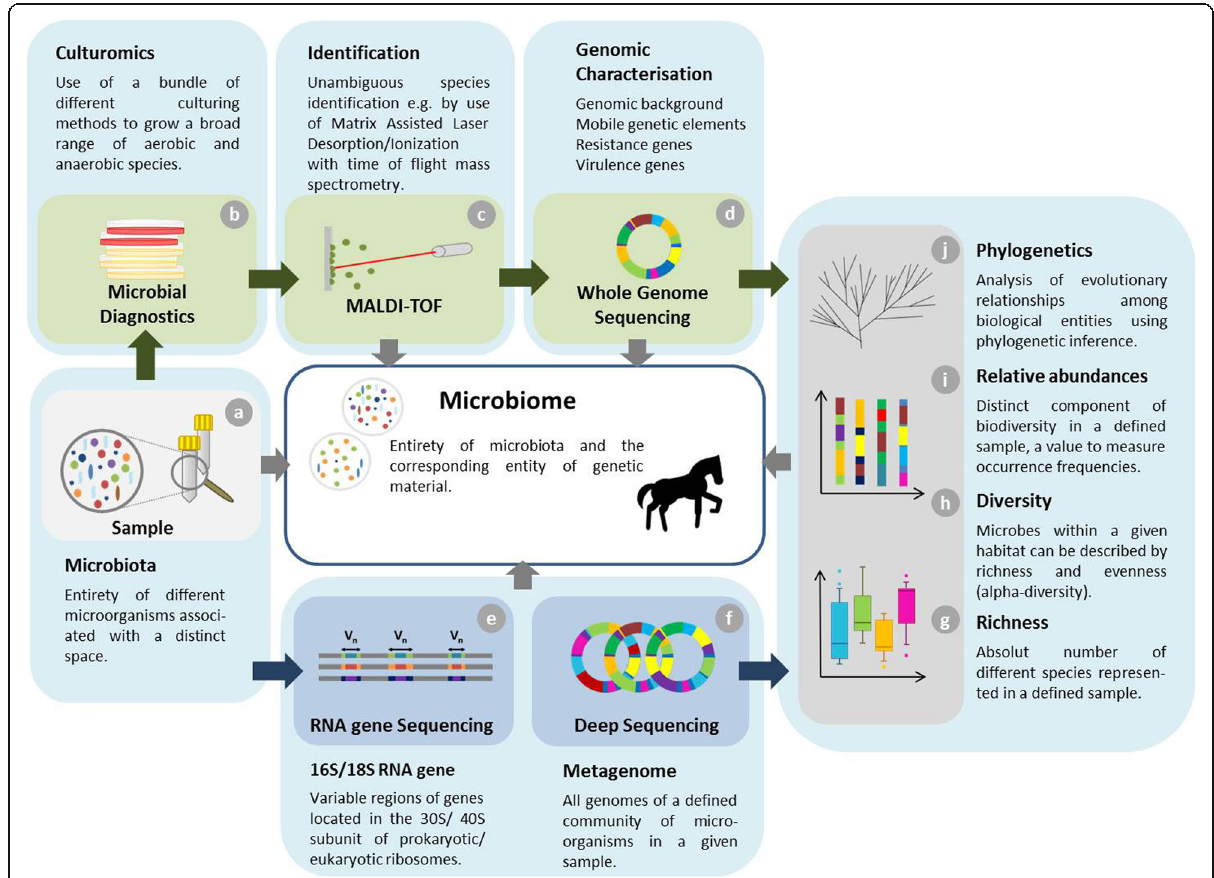
Fig. 1 Workflow and synergistic application of differt techniques to study enteral microbiomes. Integrative and synergistic workflow to study equine microbiomes starting with dividing the fresh sample ( a ) for two general processing ’ s, microbial diagnostic in terms of culturomics ( b - d ) [157] and DNA sequencing approaches ( e and f ) for population analysis ( g - i ). A broad range of different aerob and aerobic culture conditions are used to initiate growth for microbial diagnostic ( b ), followed by rapid species identification by MALDI-tof mass spectrometry ( c ). Genome sequencing ( d ) allows (novel) species identification in case MALDI-tof provided no confident result or if resistance- and virulence encoding genes [158, 159] or other factors are of particular interest within a species. Both information sources allow identification of bacterial species present in the horse microbiota and their growth conditions. The second part of the sample should be stored native at − 80 °C until DNA extraction starts for either sequencing of variable regions of 16S/18S rRNA gene ( e ) allowing characterizing and quantifying taxonomic entities or sequencing of all genomes (metagenome) present in a sample ( f ). Further bioinformatics include description of richness ( g ), diversity indices ( h ) [160 – 162], relative abundances ( i ) and phylogenetics ( j ). Combination of classical diagnostics on a large scale and different techniques available to generate genomic data enable deep insights into microbiome composition and characteristics